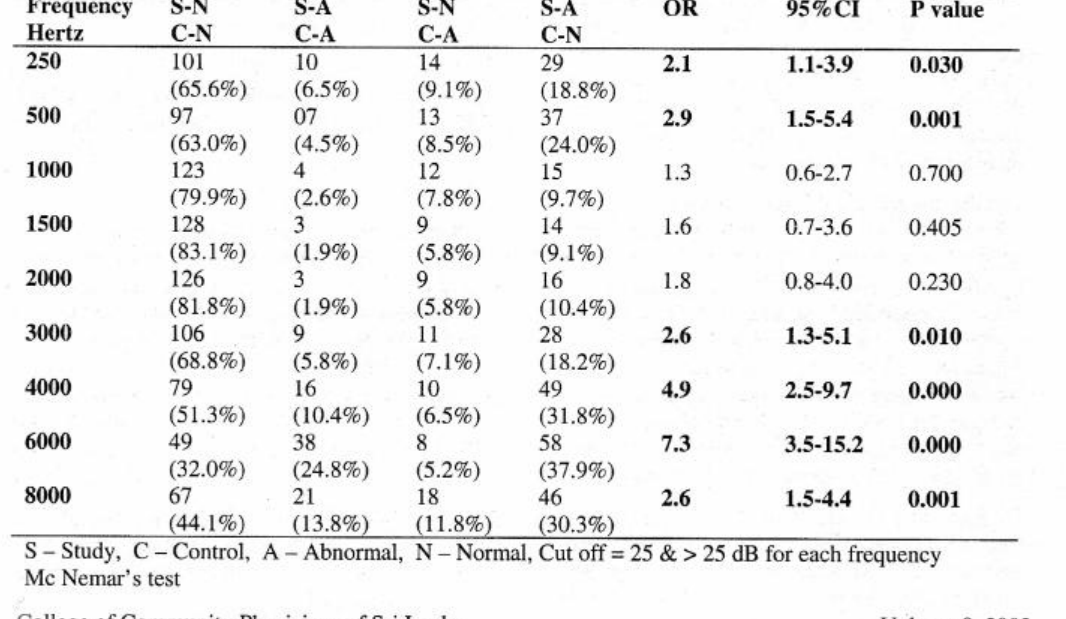
Table 2 : Impairment of hearing by frequency - Left Ear